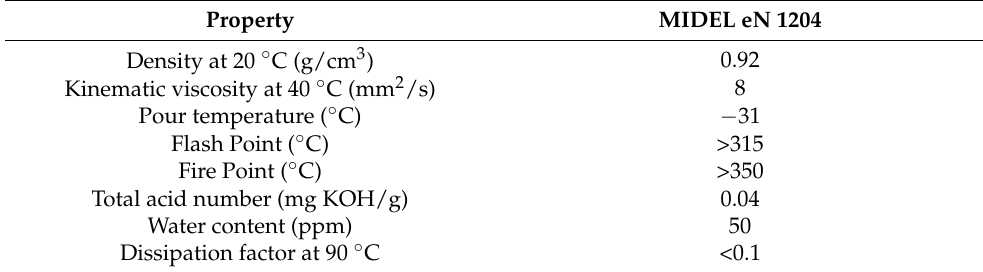
Table 1. Physicochemical properties of MIDEL eN